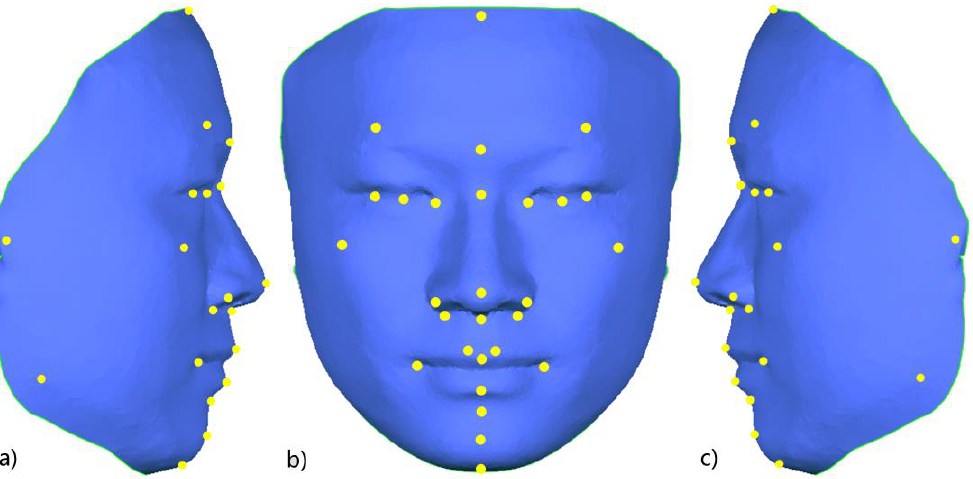
Figure 3. Schematic diagram of 32 facial anatomical landmarks on the 3D face template; ( a ) right lateral view; ( b ) frontal view; ( c ) left lateral view.